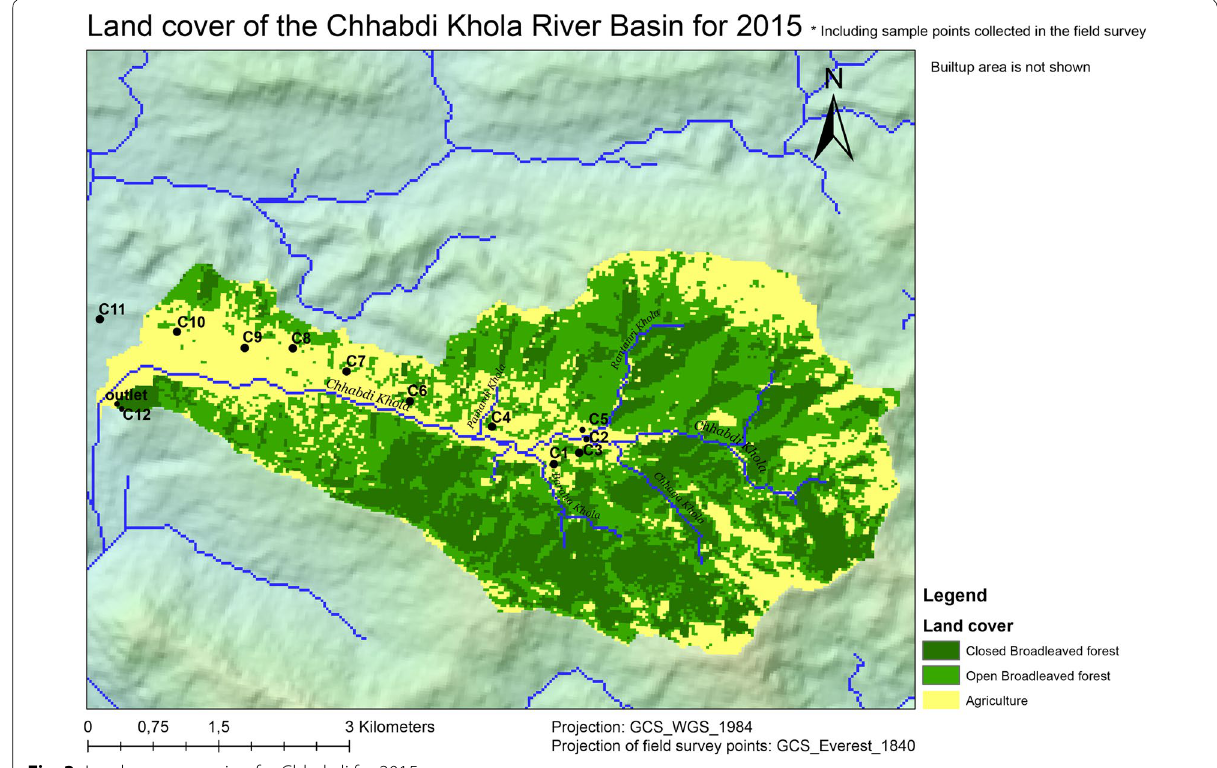
Fig. 3 Land cover mapping for Chhabdi for